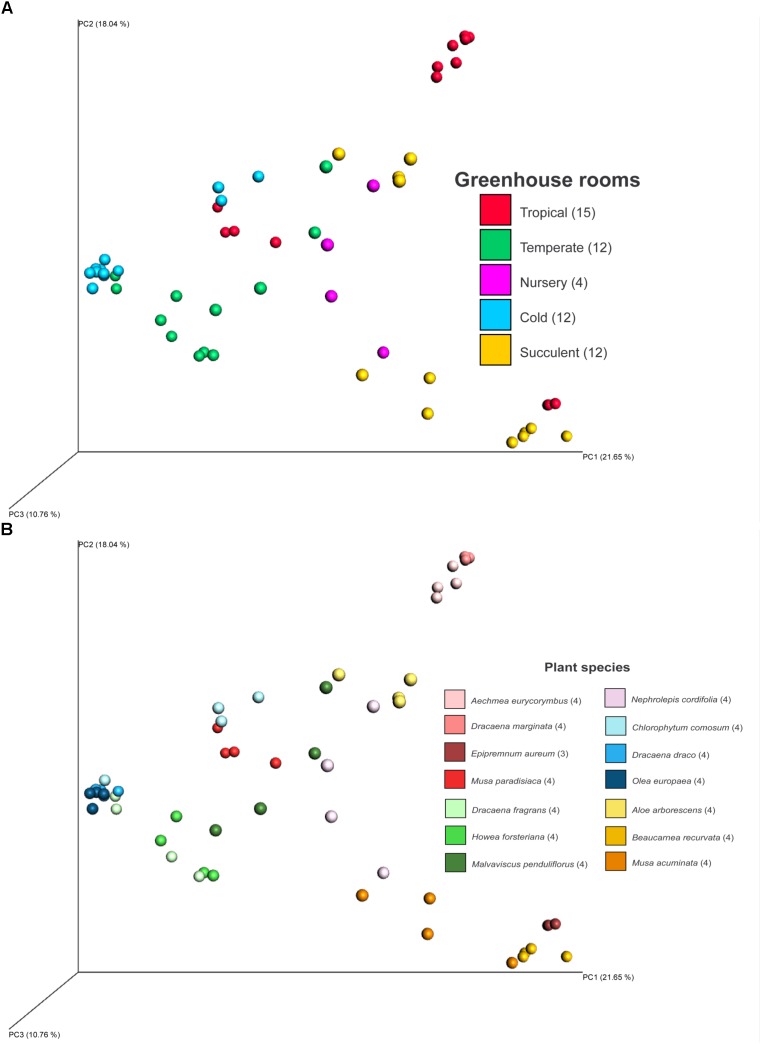
PCoA plot of fungal diversity in the phyllosphere of 14 greenhouse plants grown in different climatic conditions of a greenhouse complex. Shown samples are based on Bray-Curtis distances and colored according to different climates of different greenhouse rooms (A) and the sampled plant species (B). PCoA axis are scaled according to explained diversity. Numbers in brackets refer to amount of samples after read normalization.